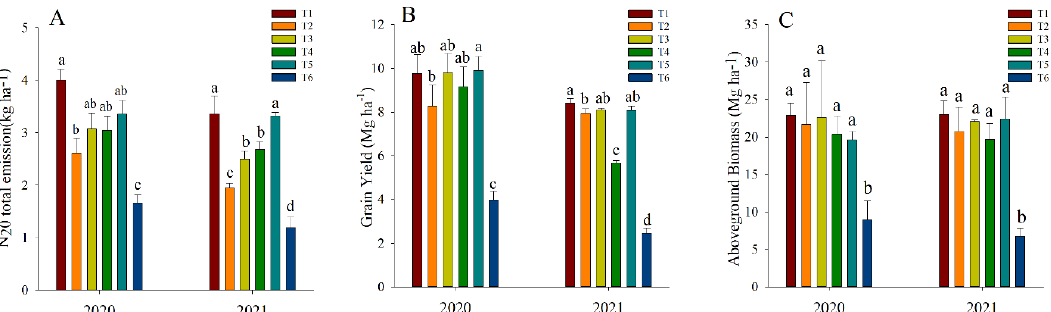
Figure 5. Total nitrous oxide emissions of the entire growth period ( A ) and grain yield ( B ) above- ground biomass ( C ). The different alphabets (a, b, c and d) show significant difference at p < 0.05. T1: inorganic fertilizer; T2: 50.0% organic fertilizer; T3: 37.5% organic fertilizer; T4: 25.0% organic